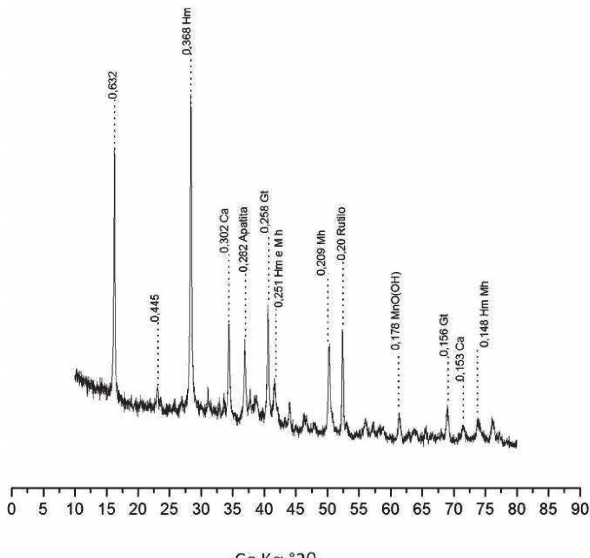
Figura 8. Difratogramas de raios-X da fração argila da camada 2B da Lapa do Malhador, após tratamento com solução de NaOH 5 mol L -1 . Hm: hematita; Mh: maghemita; Ca: calcita; Gt: goethita; Mn: manganita; Ru: rutilo; e Ap: apatita.